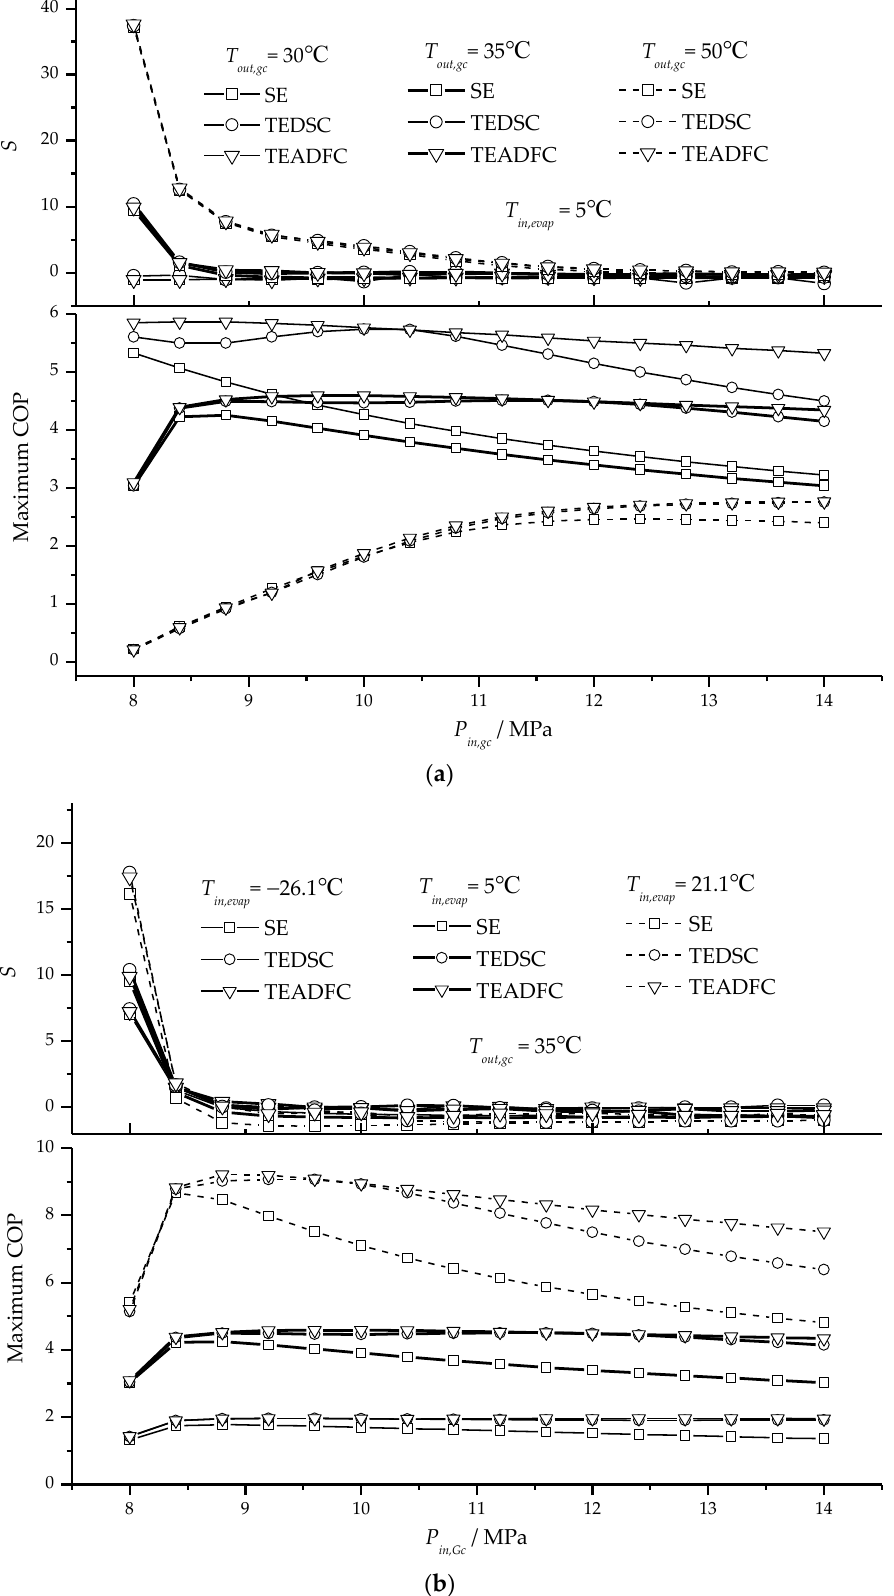
Figure 4. Sensitivity of maximum COP to gas cooler inlet pressure ( a ) T in , evap = 5 °C; ( b ) T out , gc = 35 °C.